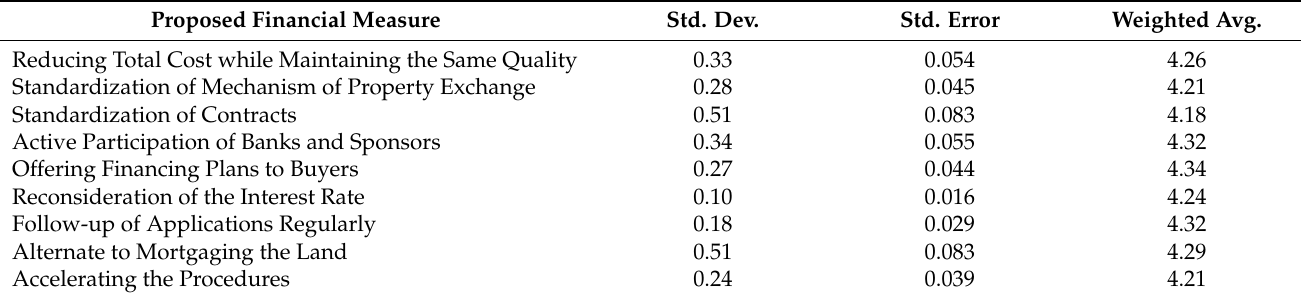
Table 2. The Weighted Average of Proposed Financial Measures Opted by